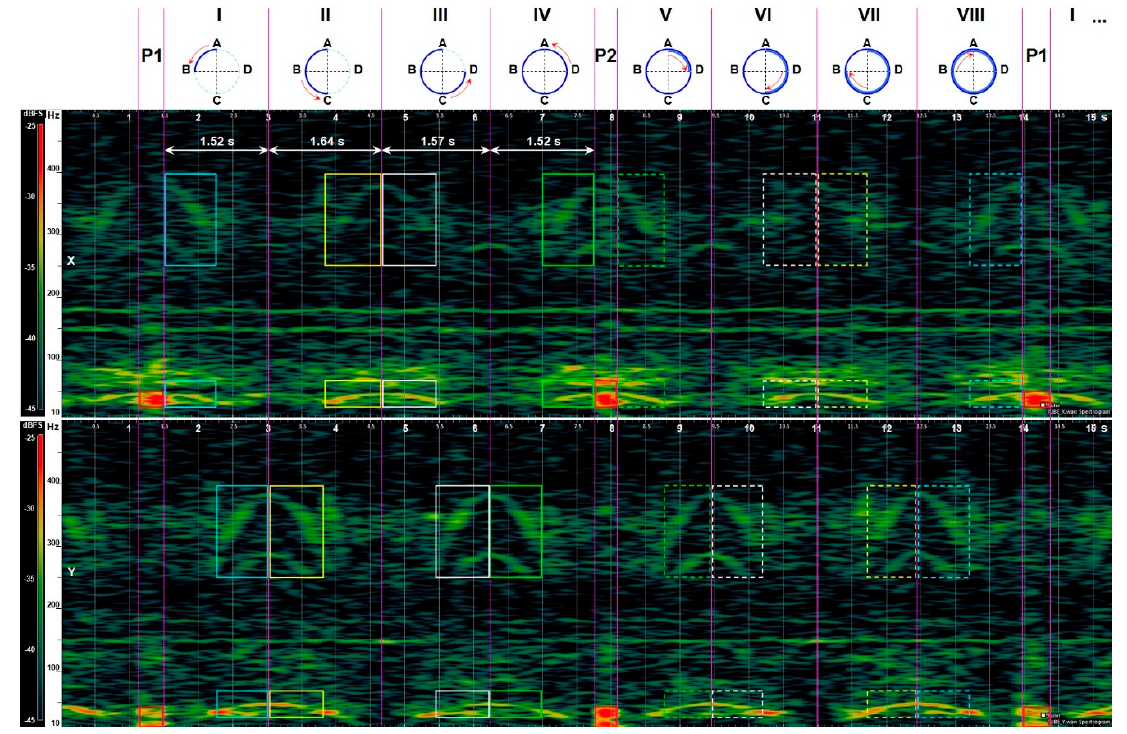
Figure 11. The spectrograms of printer vibrations when the tube object was printed. Characteristic arches and spectrum condensations can be observed for particular printing steps. Depending on the share of the X or Y component while printing particular quarters of the tube’s walls, the arches appear on X and Y spectrograms, respectively. The areas marked respectively with a continuous and a dashed line of the same color represent printing steps where the same quarters of the tube wall are printed, but when the head